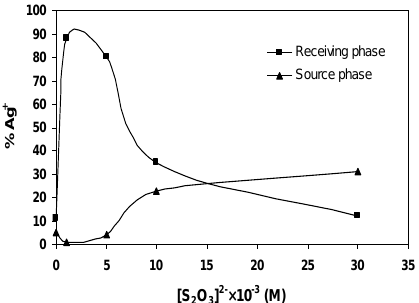
Figure 3. Effect of thiosulfate anion (S O 32- ) concentration in the receiving phase on Ag + 2 cation transport. Experimental conditions: source phase, 10 ml of 3.0×10 -4 M Ag + cation and 3.0×10 -3 M picric acid at pH 4; liquid membrane phase, 50 ml of 1.0×10 -3 M carrier in DCM; receiving phase, 5 ml of varying concentration of S O 32- at pH 3; time of transport, 4 2 hours. Table 2. Effect of different stripping agents present in the receiving phase on Ag + cation transport a .